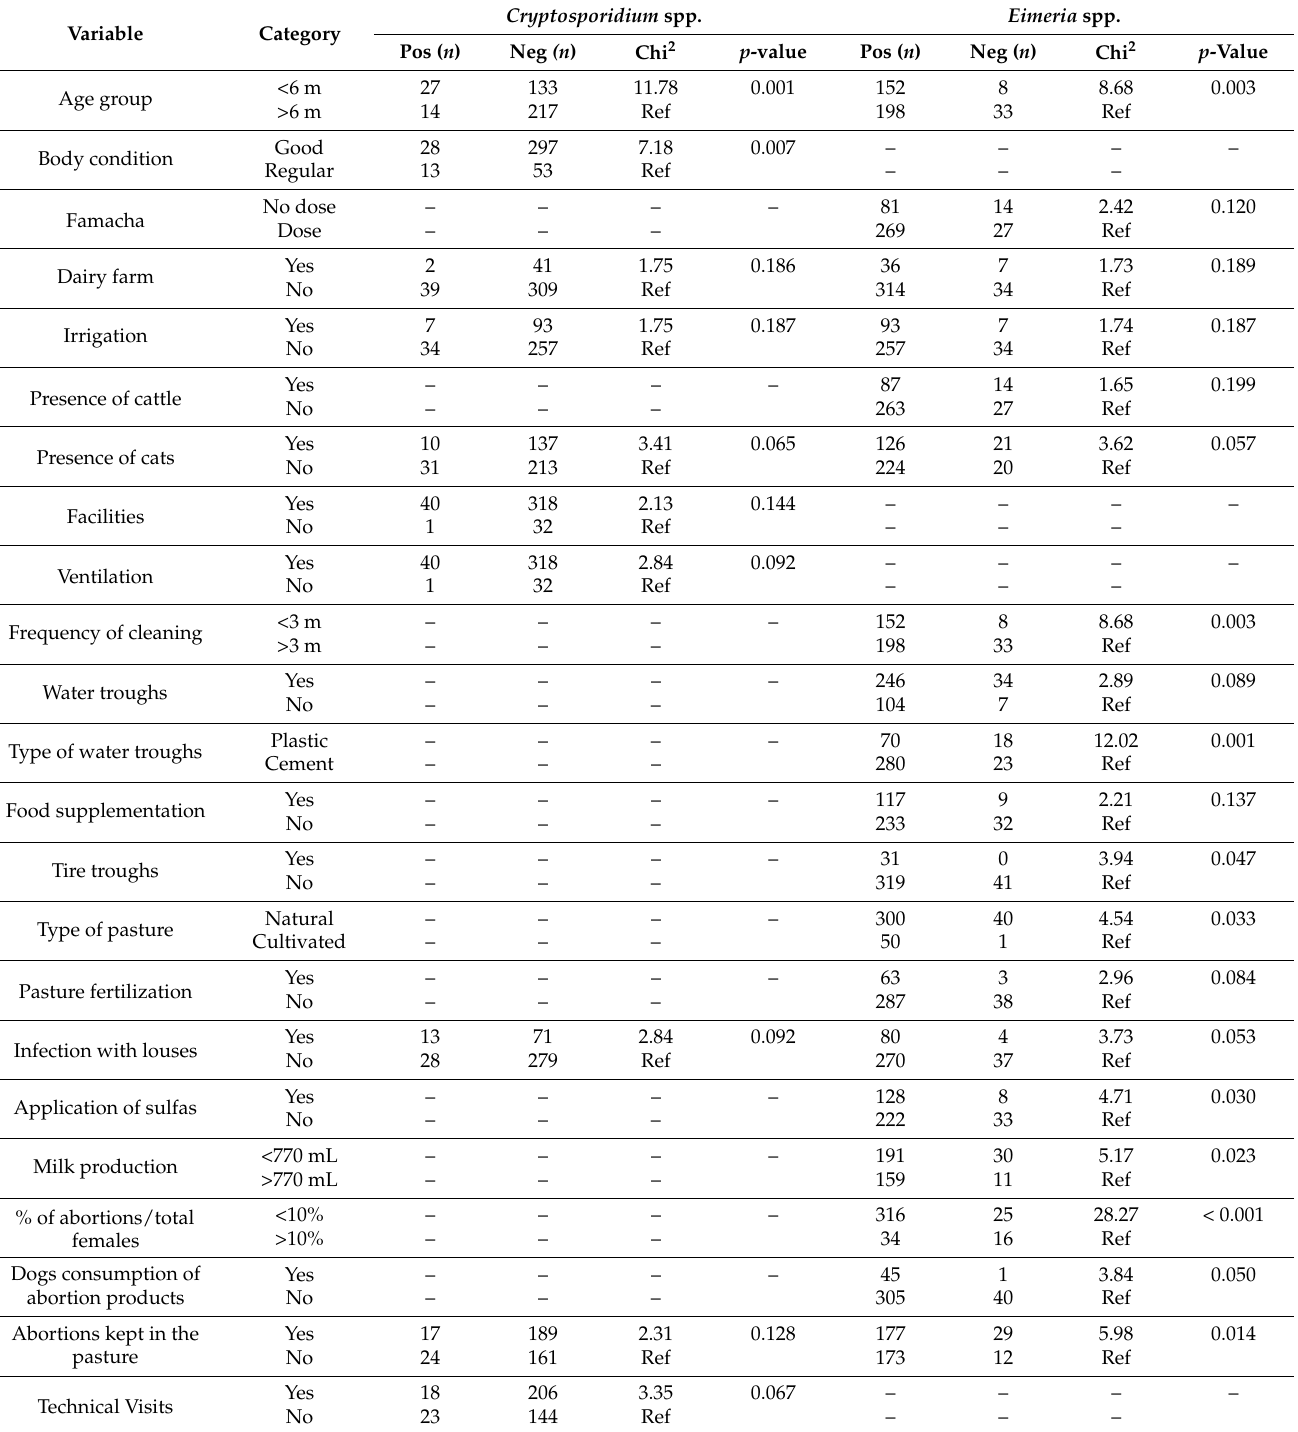
Table A3. Univariable analysis of variables associated with Cryptosporidium spp./ Eimeria spp. infec- tions in goats from Zapotillo Canton,